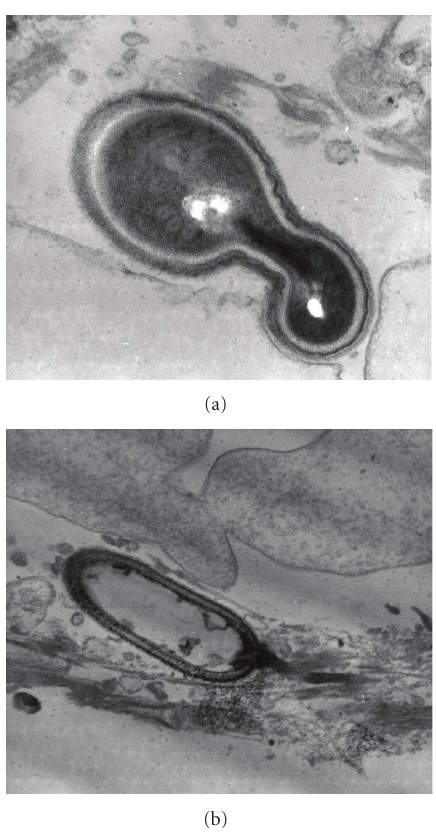
Figure 2: (a) Transmission electron microscopy demonstrates the presence of the meront of microsporidia, with the characteristic coiled polar tube. (b) Microsporidia meront hat shows the polar tube